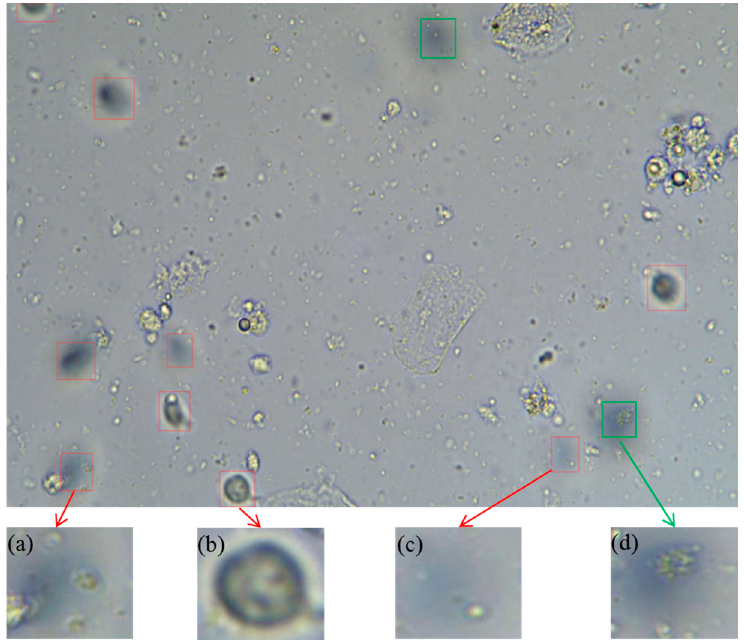
Figure 1. One frame in the video has clear formed elements. The trichomonas vaginalis (TV) and some backgrounds are marked with red and green rectangles, respectively. ( a – c ) show the enlarged TV and ( d ) shows the enlarged background.